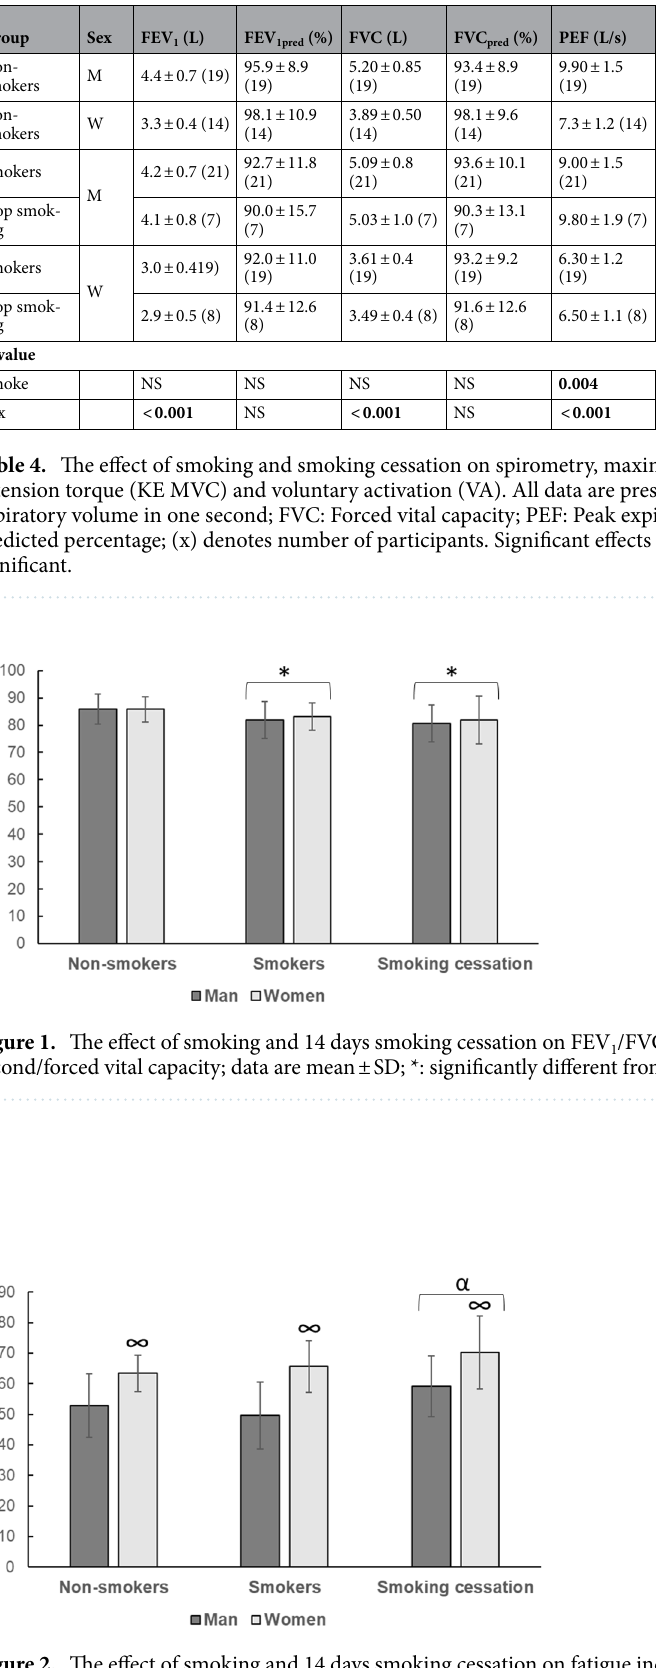
Figure 2. The effect of smoking and 14 days smoking cessation on fatigue index. Data are mean ± SD; ∞: significantly different from men at p < 0.05; α: significantly different from smokers at p <